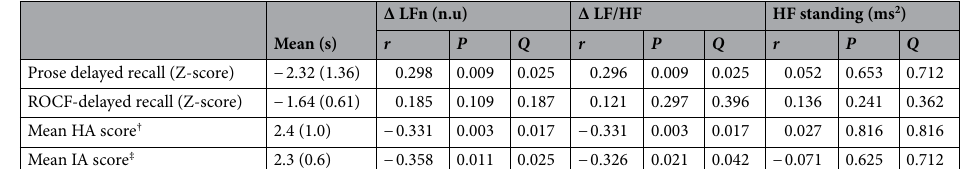
Δ LFn (n.u) Δ LF/HF HF standing (ms 2 ) Mean (s) r P